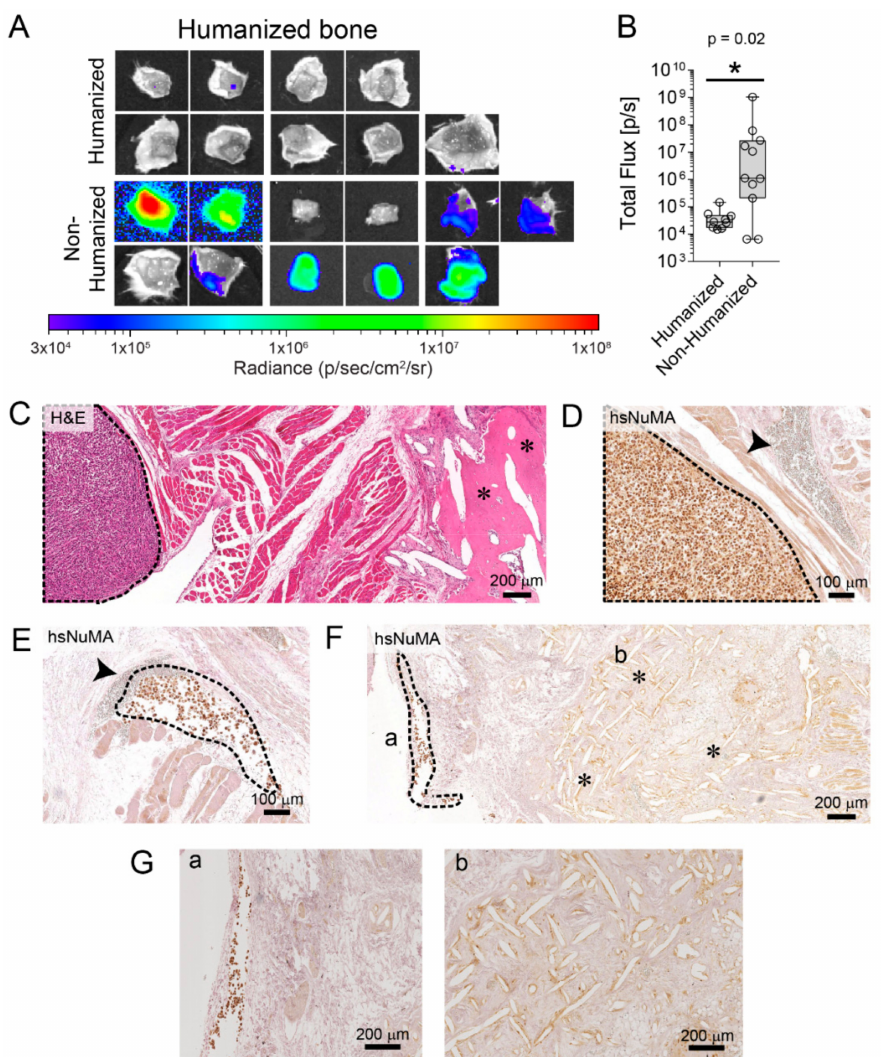
Figure 3. Humanization of the prostate reduces PC3-luc metastasis to the hTEBC. ( A ) Metastasis to the hTEBC ( B ) and corresponding BLI data quantification demonstrates that there was significantly higher tumor burden in the hTEBCs (n = 9–11 scaffolds per group), from the non-humanized prostate compared to the humanized prostate group (data are represented as individual values within box plots. Statistical analysis was performed using a Mann-Whitney U test for non-parametric data). ( C ) Histology (H&E) and ( D – G ) immunohistochemical staining for hsNuMA was used to detect PC3-luc metastases in the hTEBCs and the surrounding muscle tissue. PC3-luc cells are outlined with a black dashed line, the hTEBC scaffold fibers are indicated by asterisks (*) and blood vessels are indicated by the arrowhead. ( G ) Represent the high magnification images for part